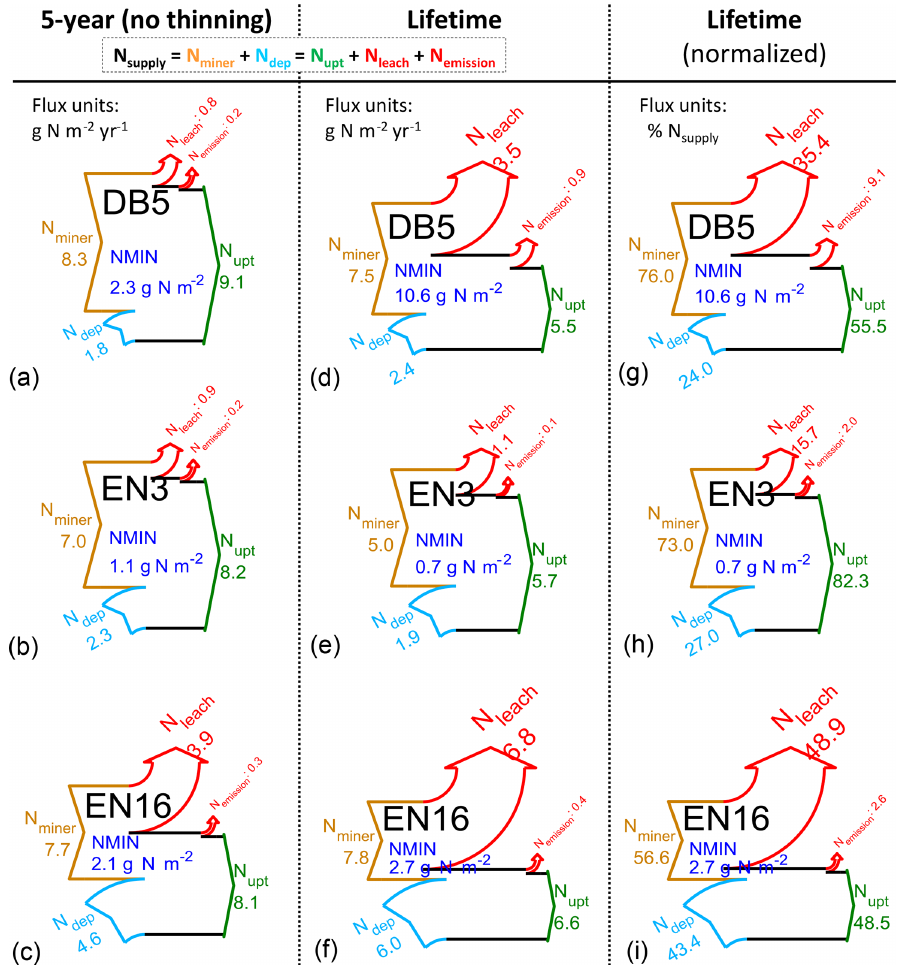
Figure 3. Modelled (BASFOR) inorganic nitrogen budgets at three example forest sites (DB5: 45-year-old Fagus sylvatica ; EN3: 120-year- old Picea abies ; EN16: 51-year-old Pseudotsuga menziesii ). Simulations were run either over the most recent 5-year period which did not include any thinning event (“5-year” in the text) or over the whole time period since the forest was established (“lifetime”). The data show ecosystem SOM mineralization ( N miner ) and atmospheric N r deposition ( N dep ), balanced by vegetation uptake ( N upt ) and the sum of losses as dissolved N ( N leach ) and gaseous NO + N 2 O ( N emission ) (units: gNm − 2 yr − 1 , a – f ; % of lifetime N supply in g – i , with N supply defined as N miner + N dep ). NMIN indicates the mean size of the soil inorganic N pool (gNm − 2 ) over the modelling period. The N uptake percentage value (g–i) corresponds to the lifetime nitrogen uptake efficiency (NUPE). The sizes of the Sankey plots are not proportional to the N fluxes of the different study